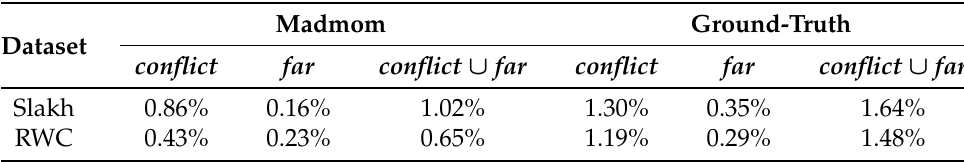
Table 3. Ratio of undetectable onset times.